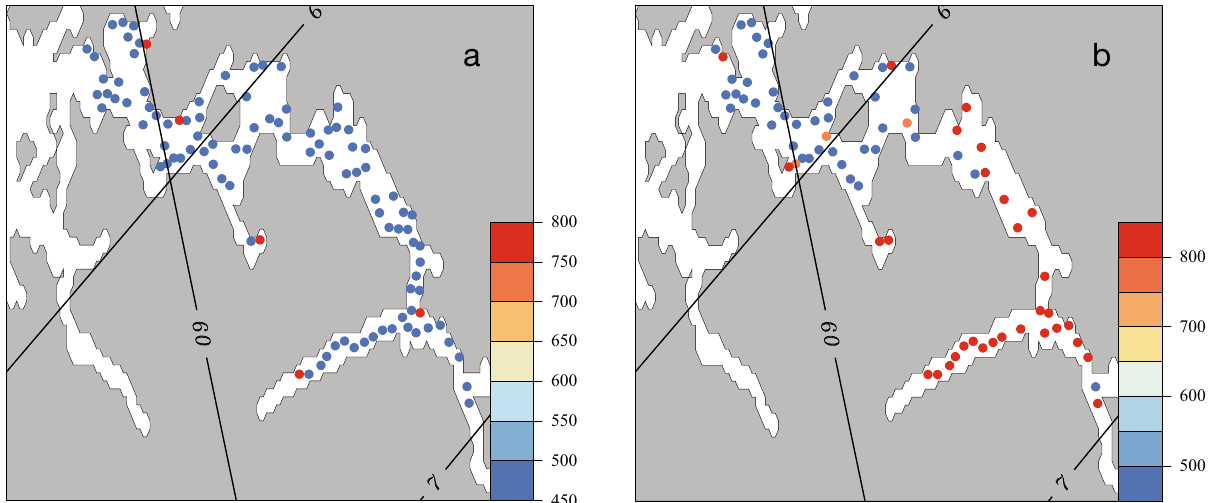
Fig. 7. Days required for each site to reach the minimum commercial size for feed production (5.0 cm) in (a) the reference simula- tion S0 and (b) S5. Note that the total number of farms is reduced in S5 as some have been removed due to starvation